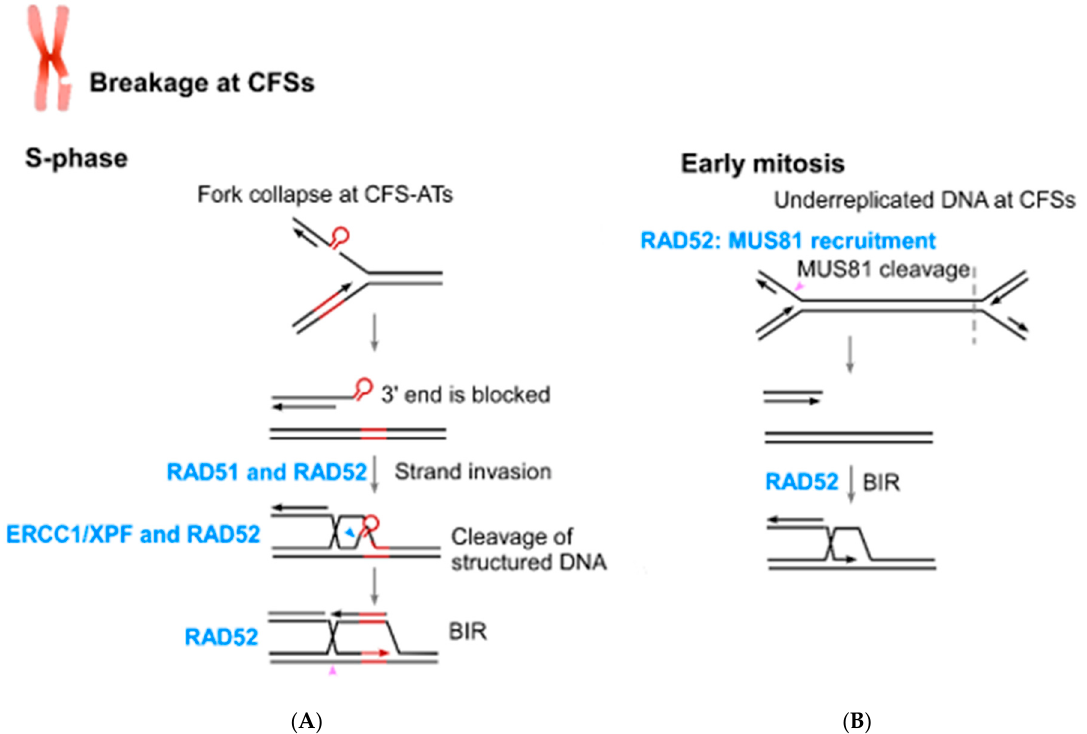
Figure 3. Multiple functions of RAD52 in coping with replication stress contribute to the maintenance of CFS stability. RAD52 is required for repairing DSBs at CFS ‐ ATs and promoting BIR upon fork collapse at CFSs in S ‐ phase ( A ). RAD52 is also required for recruiting MUS81 to cleave underreplicated DNA at CFSs and promote BIR in early mitosis ( B ).